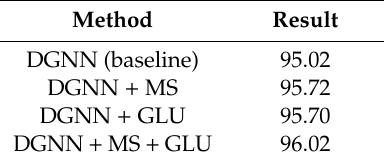
Table 5. Experimental results of the ablation study. MS, master